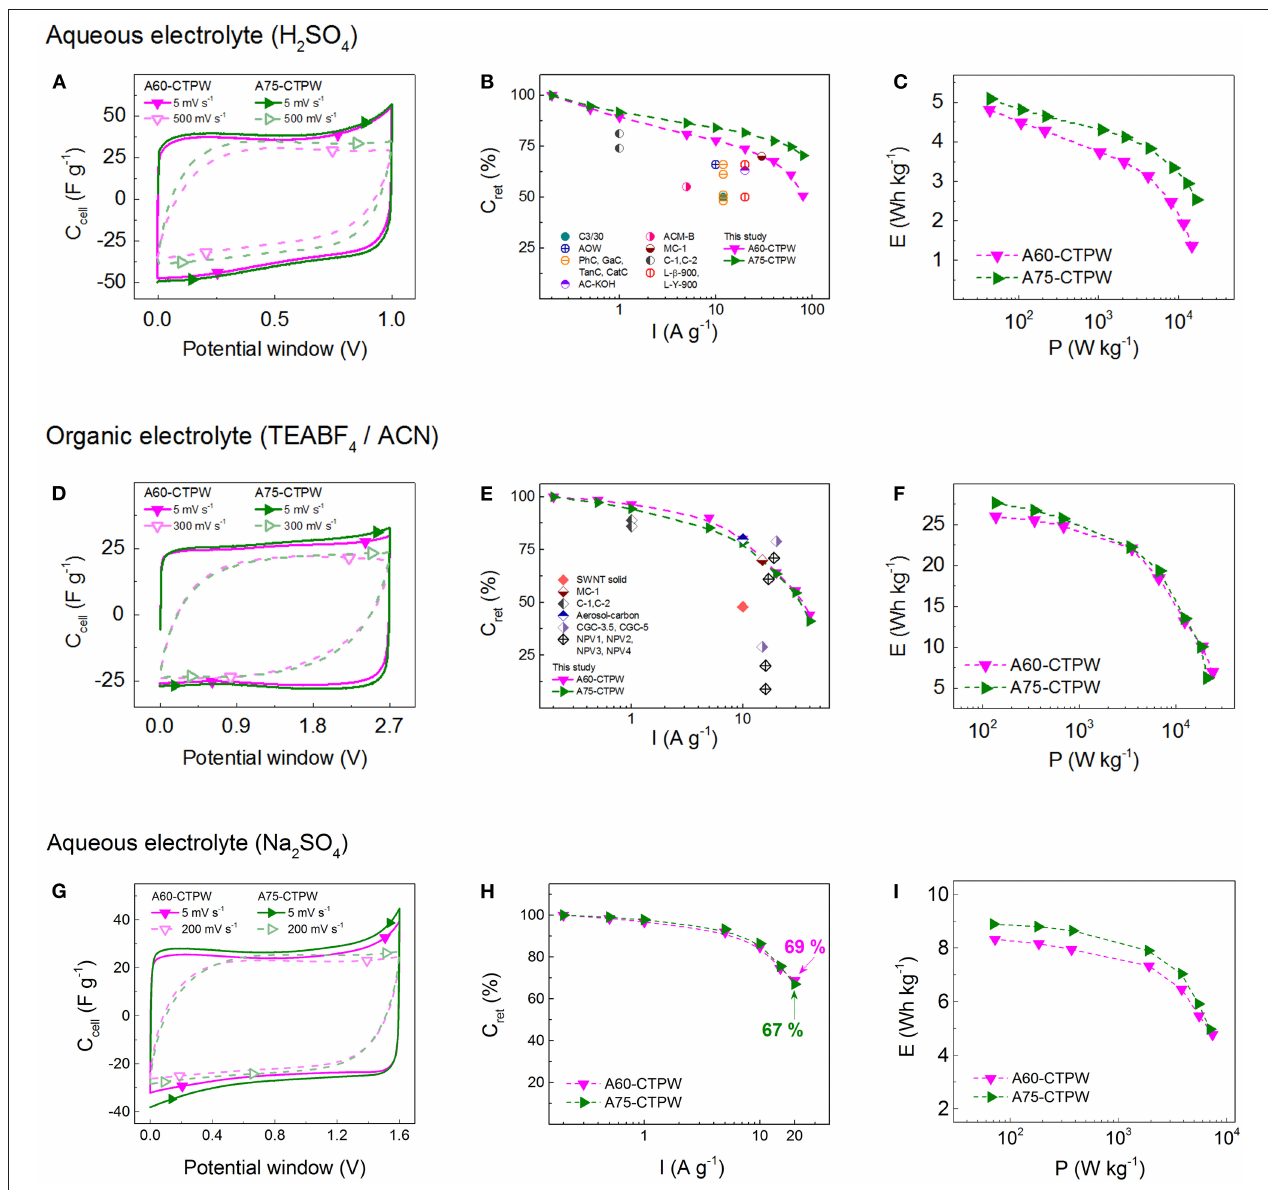
FIGURE 12 | Electrochemical performances of activated OMCs derived from mimosa tannin: (A,D,G) CV curves; (B,E,H) capacitance retention as a function of applied current; and (C,F,I) specific energy as a function of specific power (Ragone-like graphs) calculated from the GCD curves. The tests were carried out in